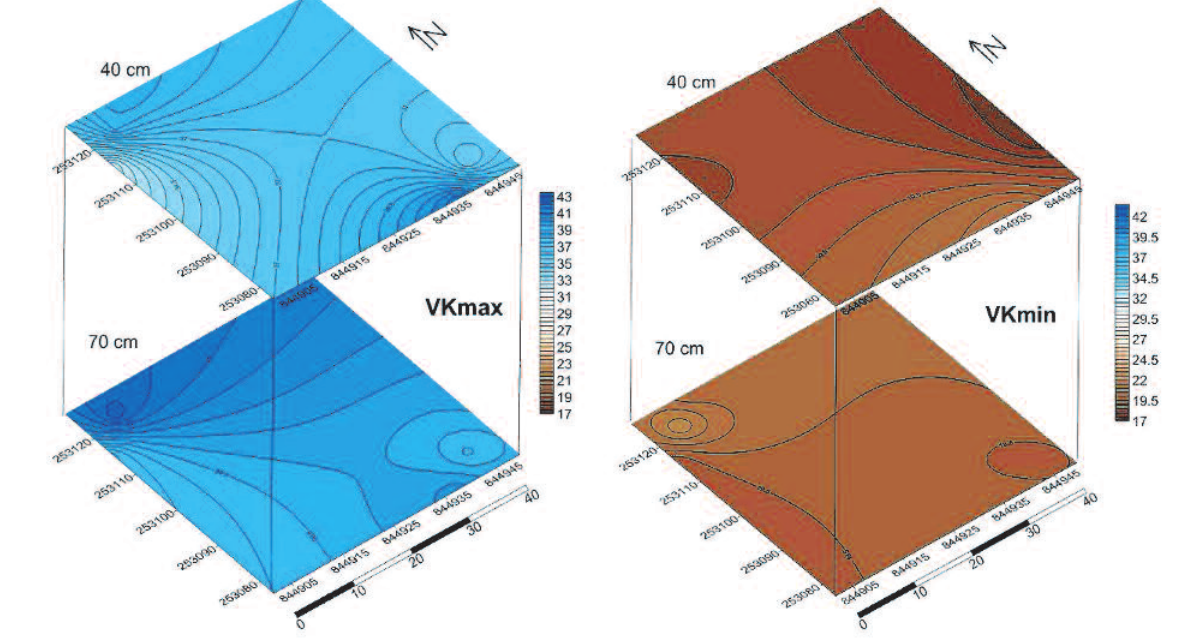
Figure 7: Total and field watercapacity of the soil